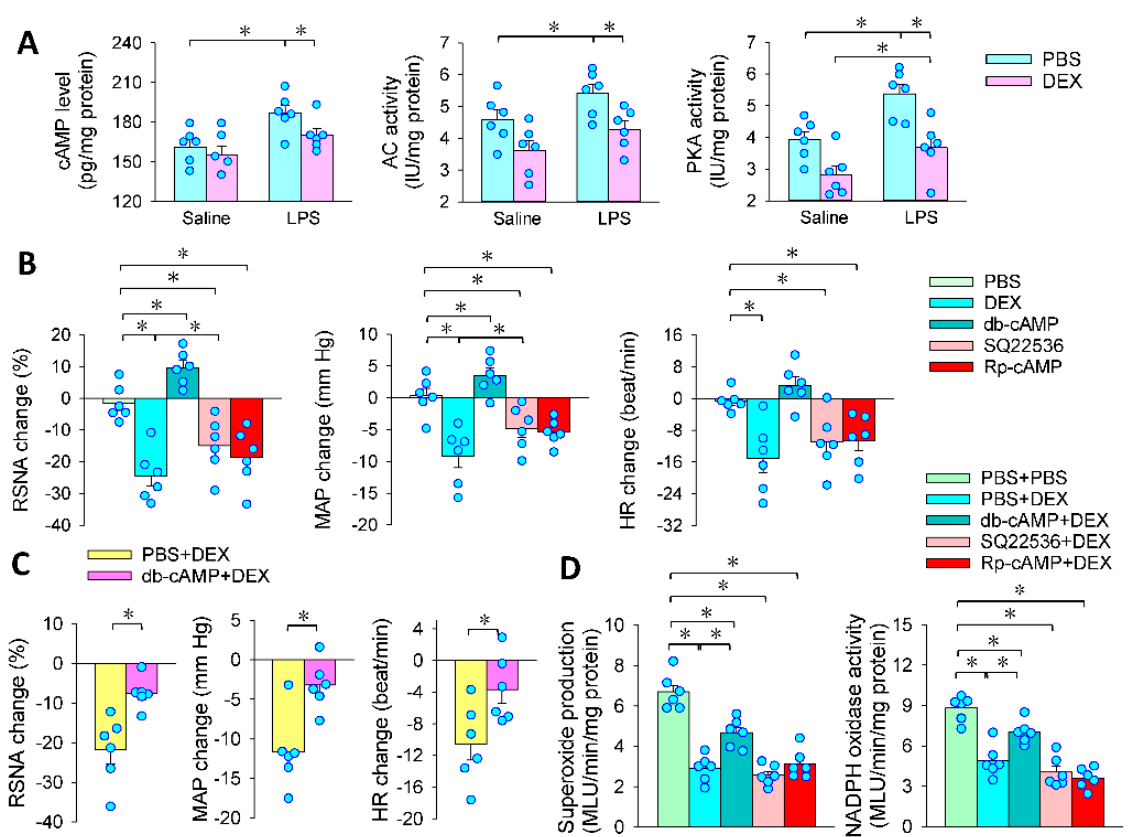
Figure 5. The cAMP-PKA pathway contributes to the effects of DEX in LPS-treated rats. PVN microinjection was carried out 24 h after the intraperitoneal injection of LPS. ( A ) effects of DEX